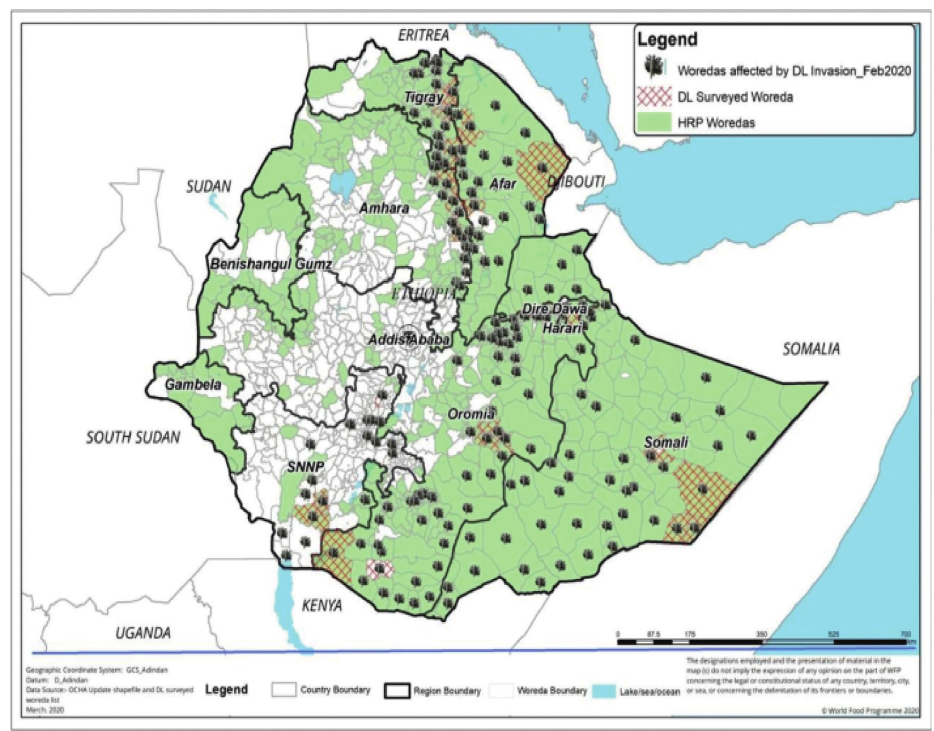
Figure 1: Map of affected areas in Ethiopia (source: